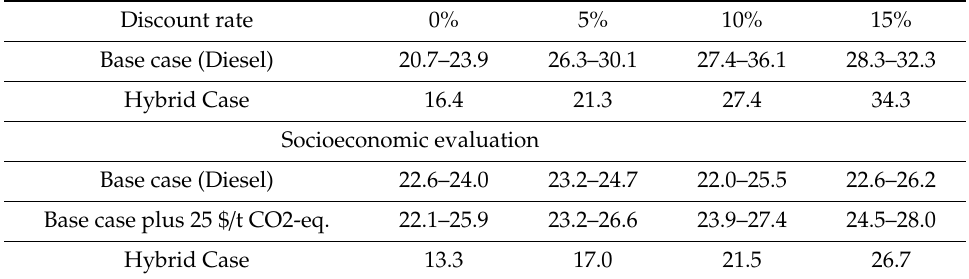
Table 2. Levelised cost depending on di ff erent discount rates (in US cents /